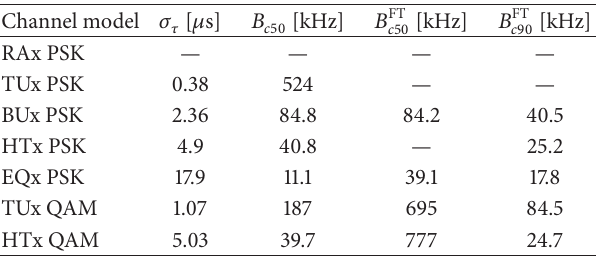
Figure 20: Histogram of coherence bandwidth values estimated from Fourier transform of PDP for correlation level 0.9 in flat terrain. Table 4: Coherence bandwidth for channel models defined in TETRA